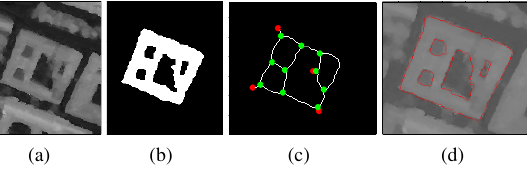
Figure 1: (a) A sub-part of the original Worldview2 satellite DSM ( D ( x; y ) ), (b) After applying local thresholding (sub-part of B D ( x; y ) ), (c) Skeleton of the building in the same sub-part of B D ( x; y ) , (d) Detected building